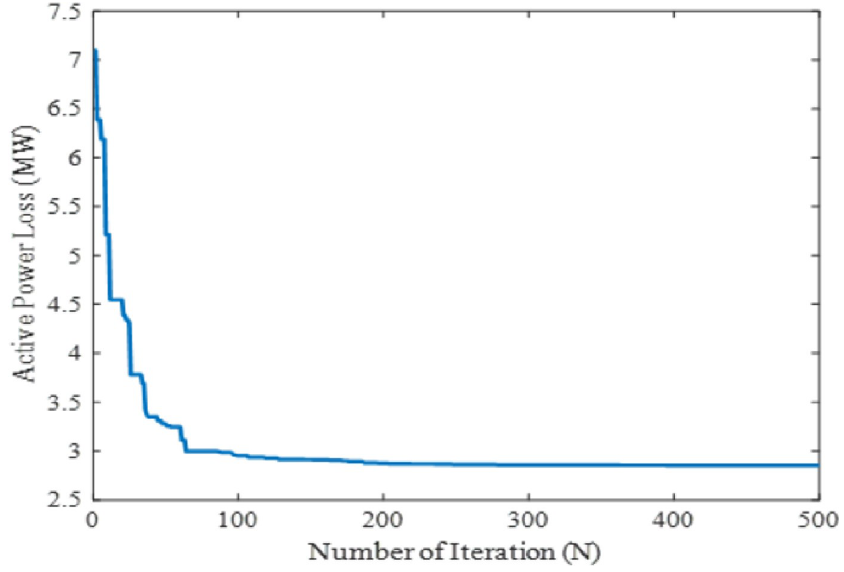
Fig 5. Convergence property of the proposed MPA for case